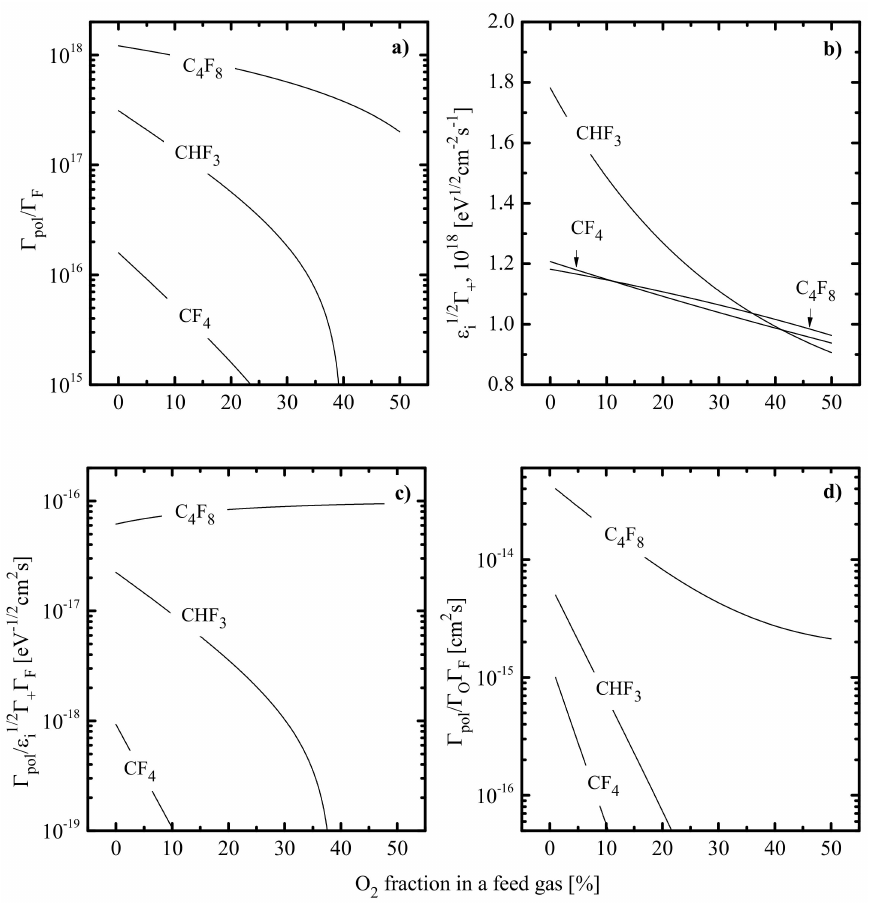
Figure 9. Fluxes and flux-to-flux ratios characterizing etching and polymerization kinetics in 50% CF 4 + O 2 + Ar ( a ), 50% CHF 3 + O 2 + Ar ( b ) and 50% C 4 F 8 + O 2 + Ar ( c ) plasmas at p = 6 mTorr, W = 700 W and W dc = 200 W: ( a ) Γ pol / Γ F ratio characterizing polymer deposition rate; ( b ) param- √ ε i Γ + characterizing polymer etching rate under the condition of M i ≈ const.; ( c ) parameter eter √ Γ ε i Γ + Γ F characterizing the change in polymer film thickness due to the physical etching pol / pathway; ( d ) parameter Γ pol / Γ O Γ F characterizing the change in polymer film thickness due to the chemical etching